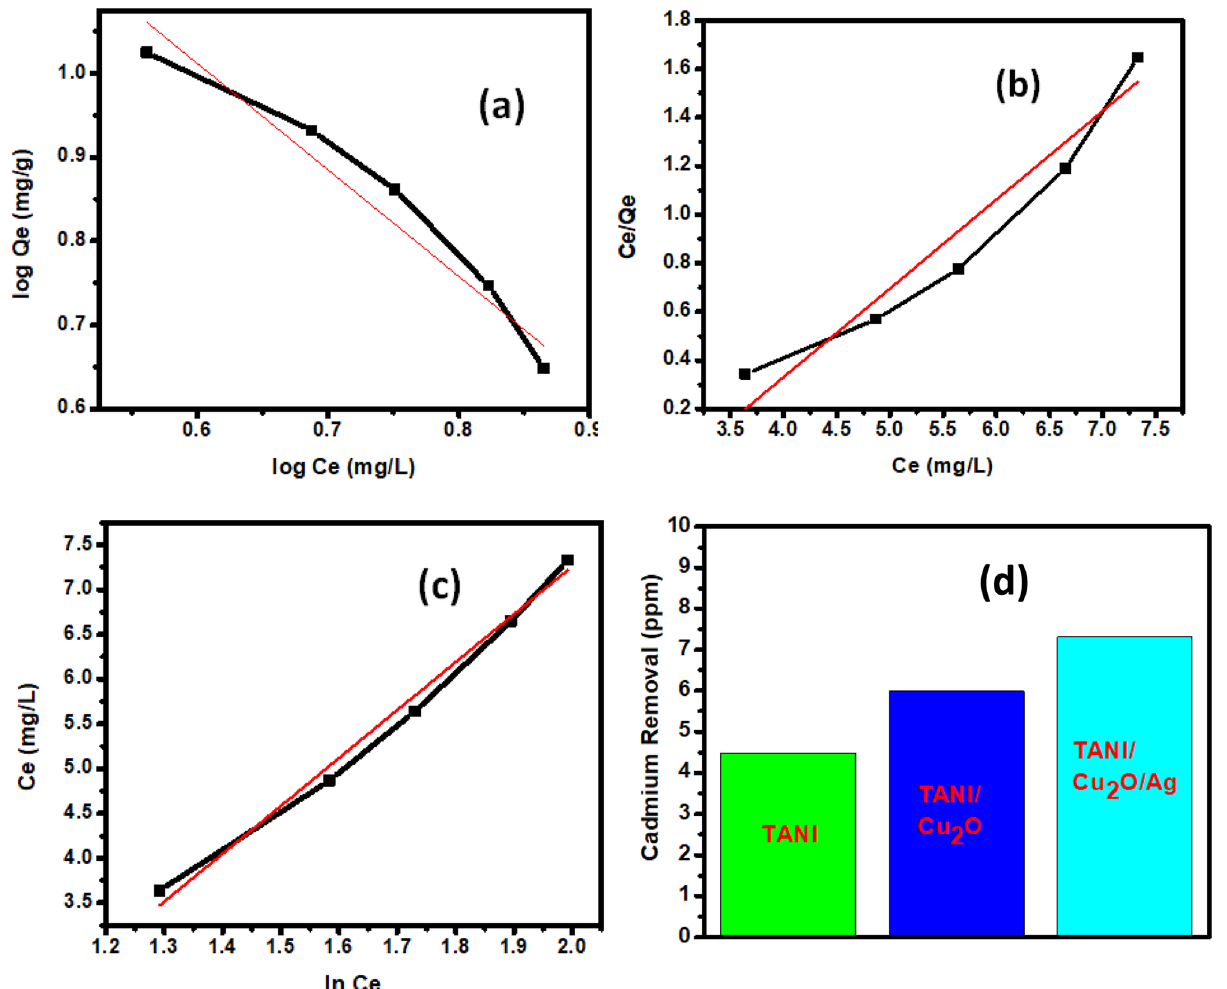
Figure 12. Adsorption isotherms of ( a ) Freundlinch, ( b ) Langmuir, ( c ) Temkin and ( d ) removal of Cd 2+ (mg/L) by prepared